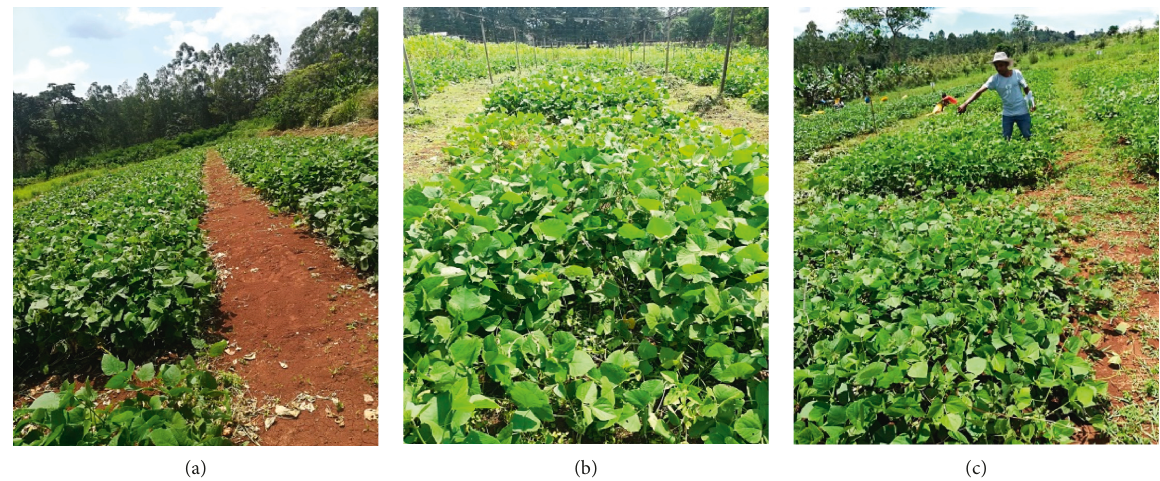
Figure 2: Field photograph illustrations to Tepi (a), Bechi, (b) and Kite (c) testing sites. Table 8: Average number of seeds per pod of different accessions of Lablab purpureus at Tepi, Bechi, and Kite testing sites. Lablab accessions